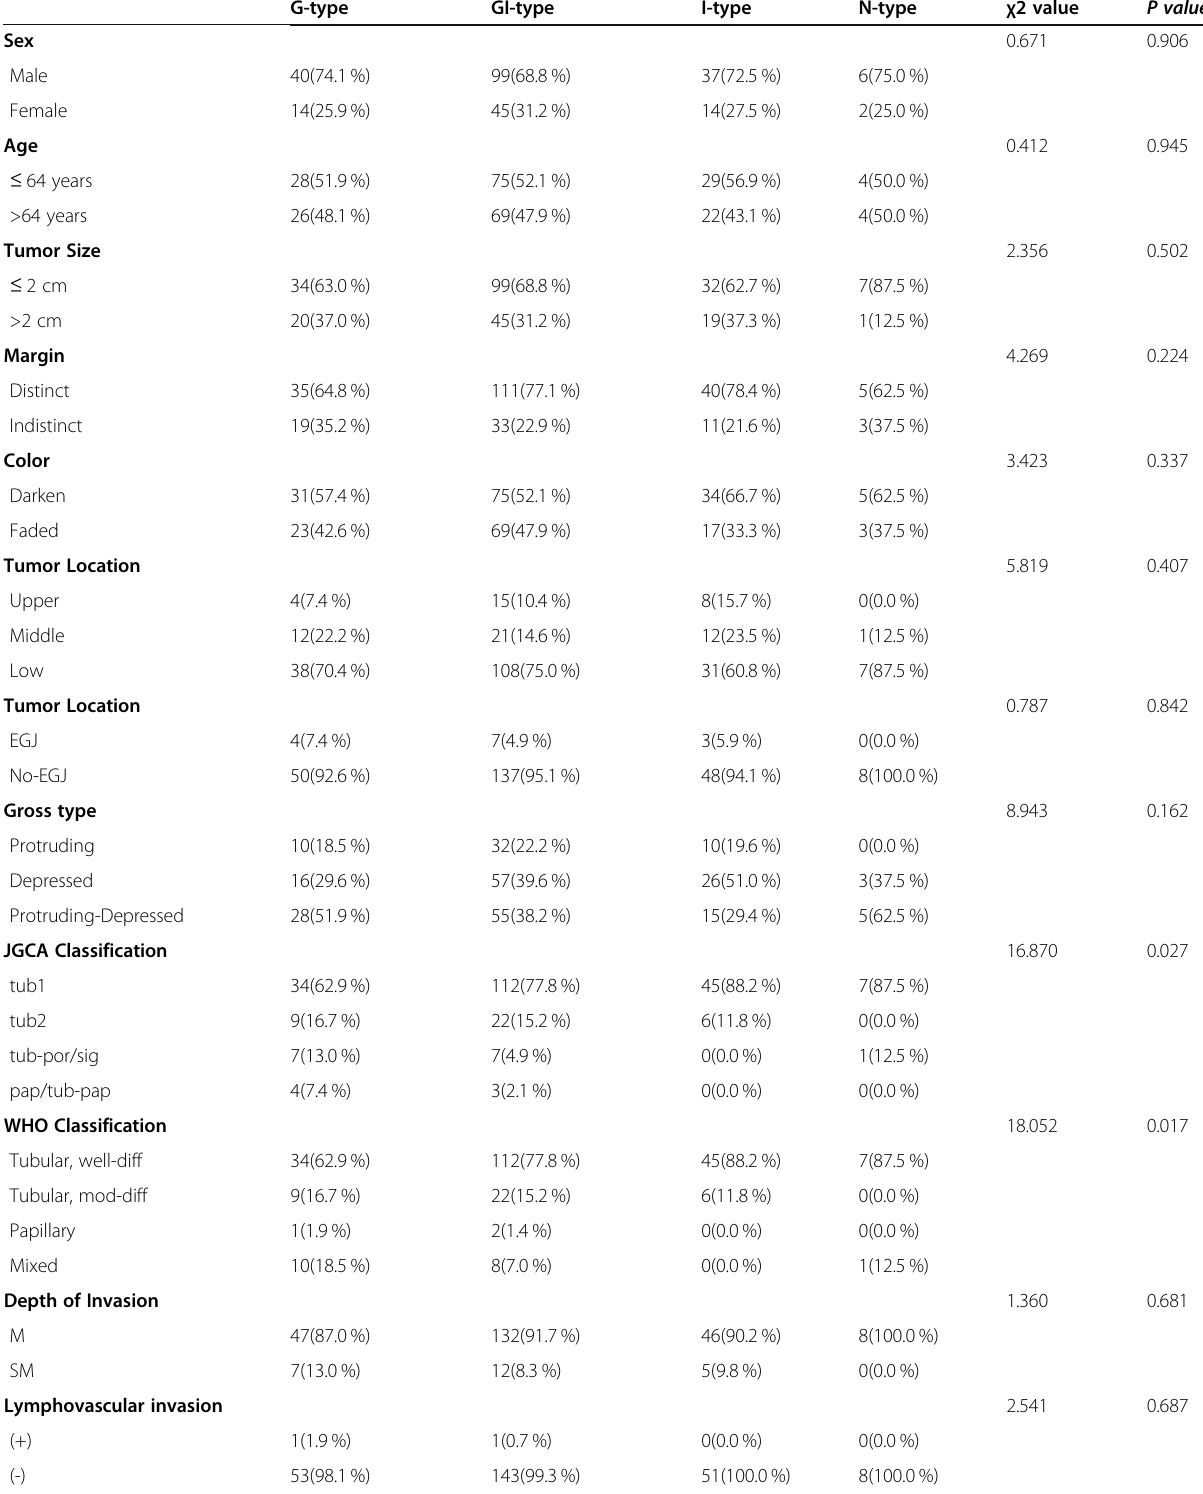
Table 1 Relationship between Mucin Phenotypes and Clinicopathological